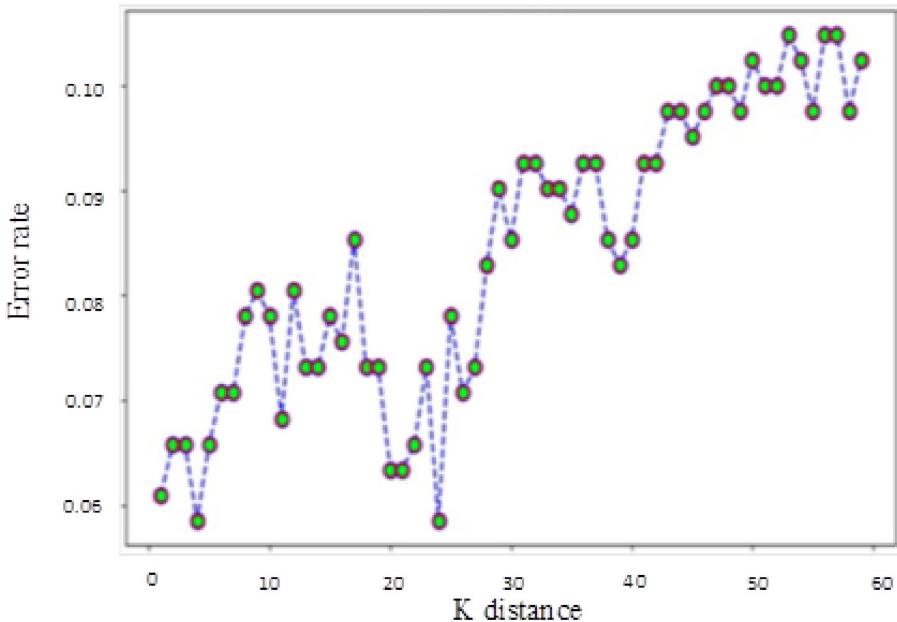
Figure 8. Relationship between K distance and error rate in KNN classifier